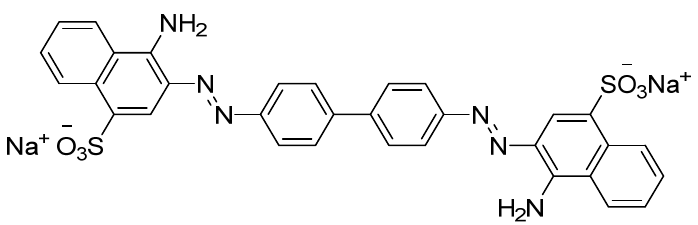
Figure 1. Chemical structure of Congo Red (CR).